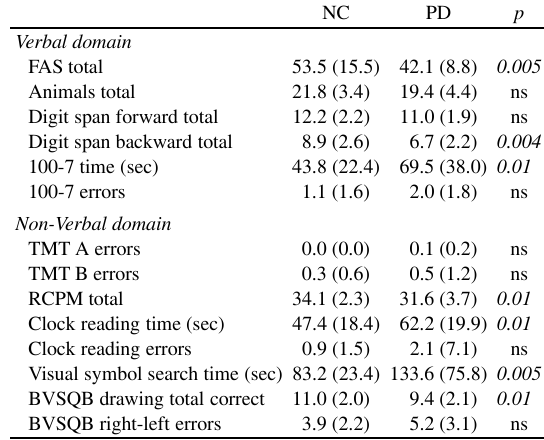
Table 2 Neuropsychological performance. Raw score mean values